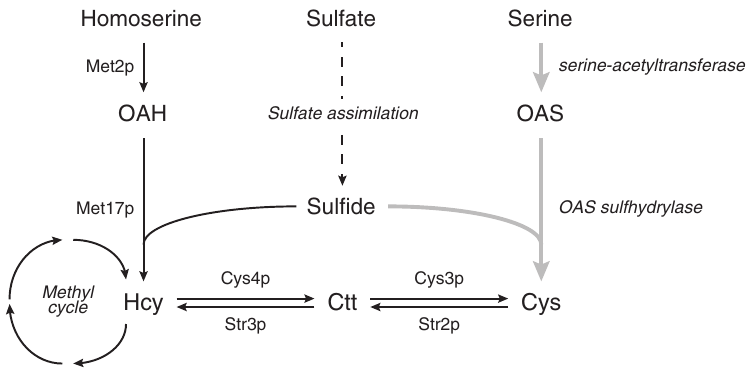
Figure 2 The sulfur metabolic pathway in Saccharomyces cerevisiae . Metabolic routes are indicated by black arrows. The de novo synthetic pathway of cysteine that is introduced to increase the intracellular cysteine levels is indicated by gray arrows. Ctt, cystathionine; OAS, O